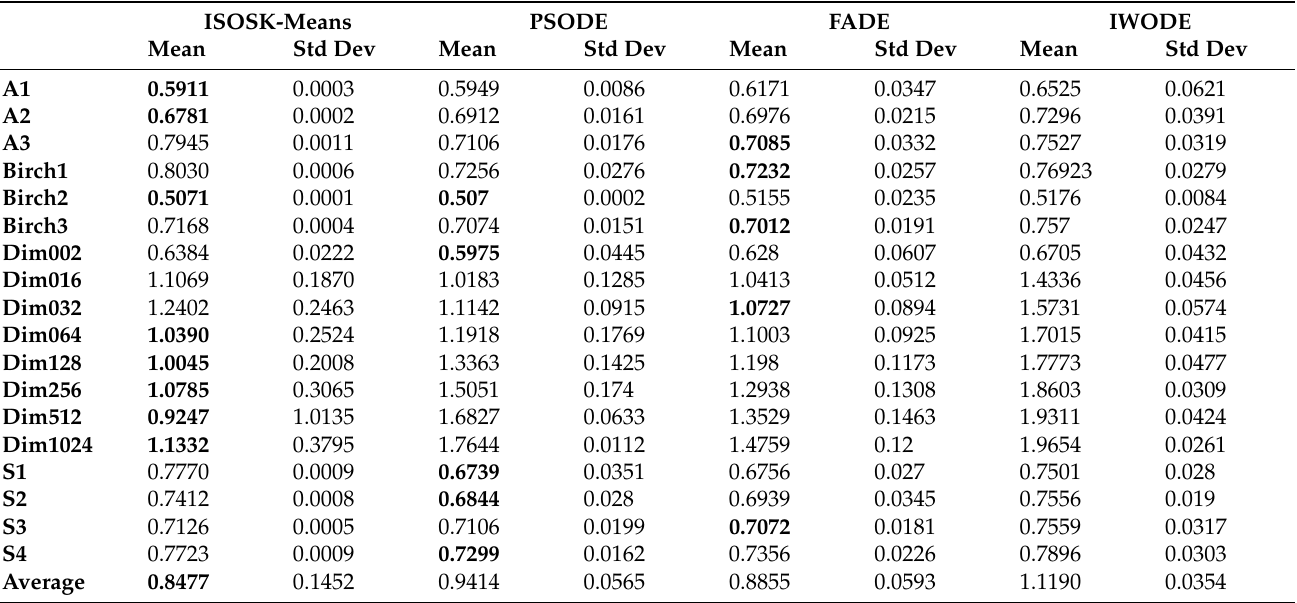
Table 7. Performance comparison of ISOSK-means with other hybrid metaheuristic algorithms from literature on 18 synthetic